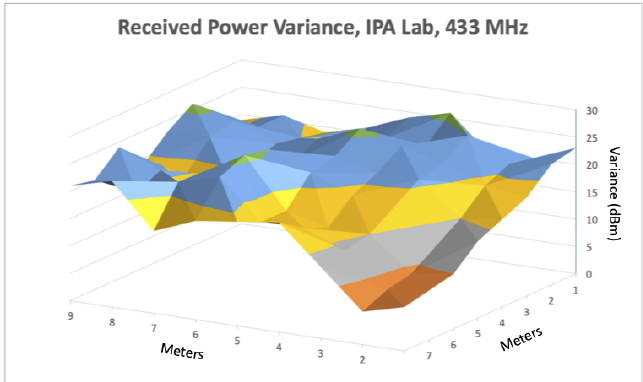
Figure 8. Received signal variance using 433 MHz transceivers in the IPA engineering lab. Received signal power levels were collected at one meter increments within the space that contained the path we used for localization